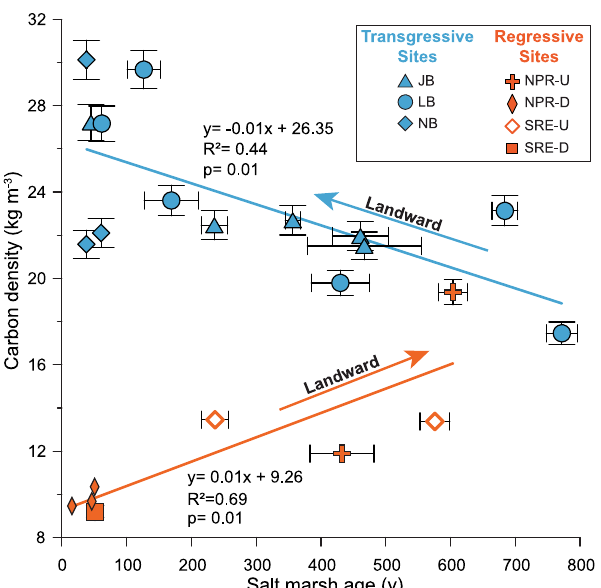
Fig. 5 Carbon density vs. salt marsh age. The carbon density of salt marsh sediment is higher in transgressive than regressive salt marshes. As the age of regressive and transgressive salt marshes increased and decreased, respectively, carbon density increased. The oldest areas of regressive salt marshes and the youngest areas of transgressive salt marshes are positioned at the upland boundary, indicating the carbon density of salt marsh sediment progressively increases in a landward direction from the estuary. Shapes are plotted at median values and error bars represent 95% con fi dence intervals (error bars <symbol size not